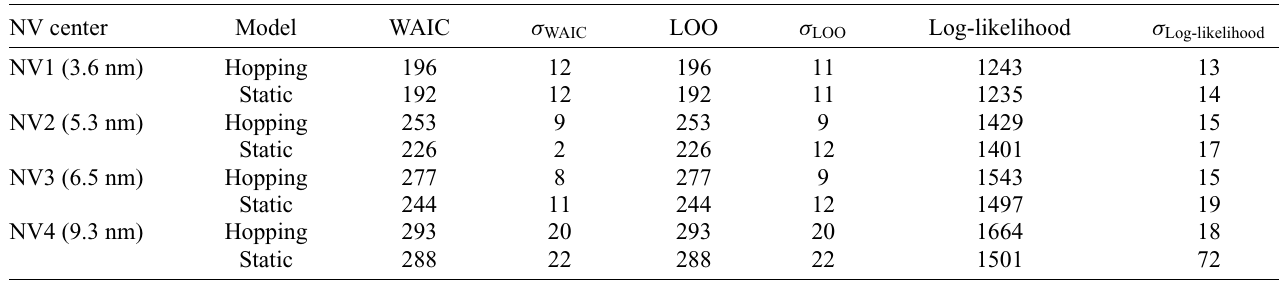
TABLE II. Model comparisons between static spins (single exponent) and configurational averaging models for four highly sampled NV center